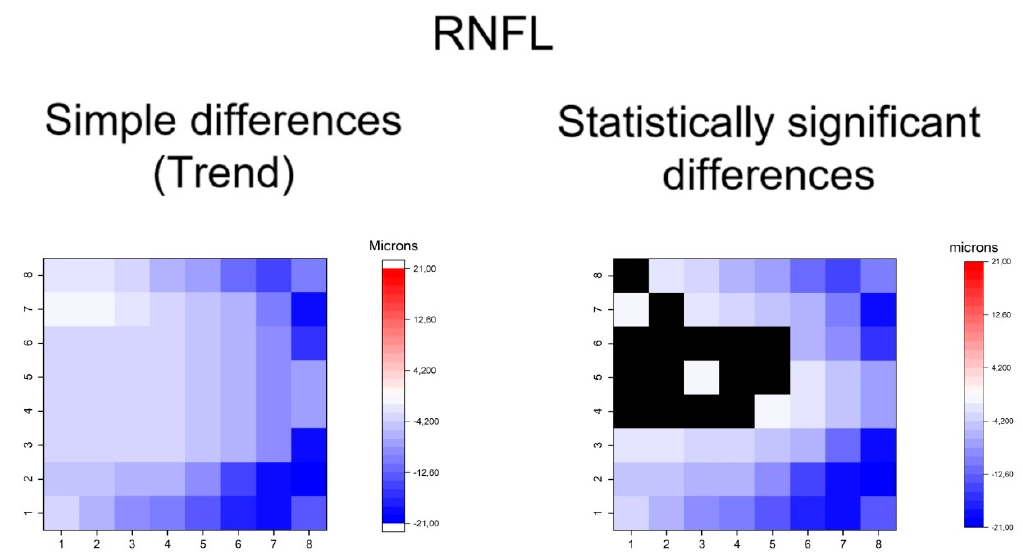
Figure 4. Heatmaps showing differences in macular retinal nerve fiber layer (mRNFL). Left map: this heatmap represents simple differences of mean thickness between OHT group and early POAG group in each superpixel giving an idea of the trend. Right map: the heatmap represents statistically significant differences ( p < 0.05) of the mean thickness between groups in each superpixel. No significant difference ( p ≥ 0.05) is represented in black. Range of significant OHT ‐ POAG differences in superpixels between − 20.70 and − 1.35 microns.